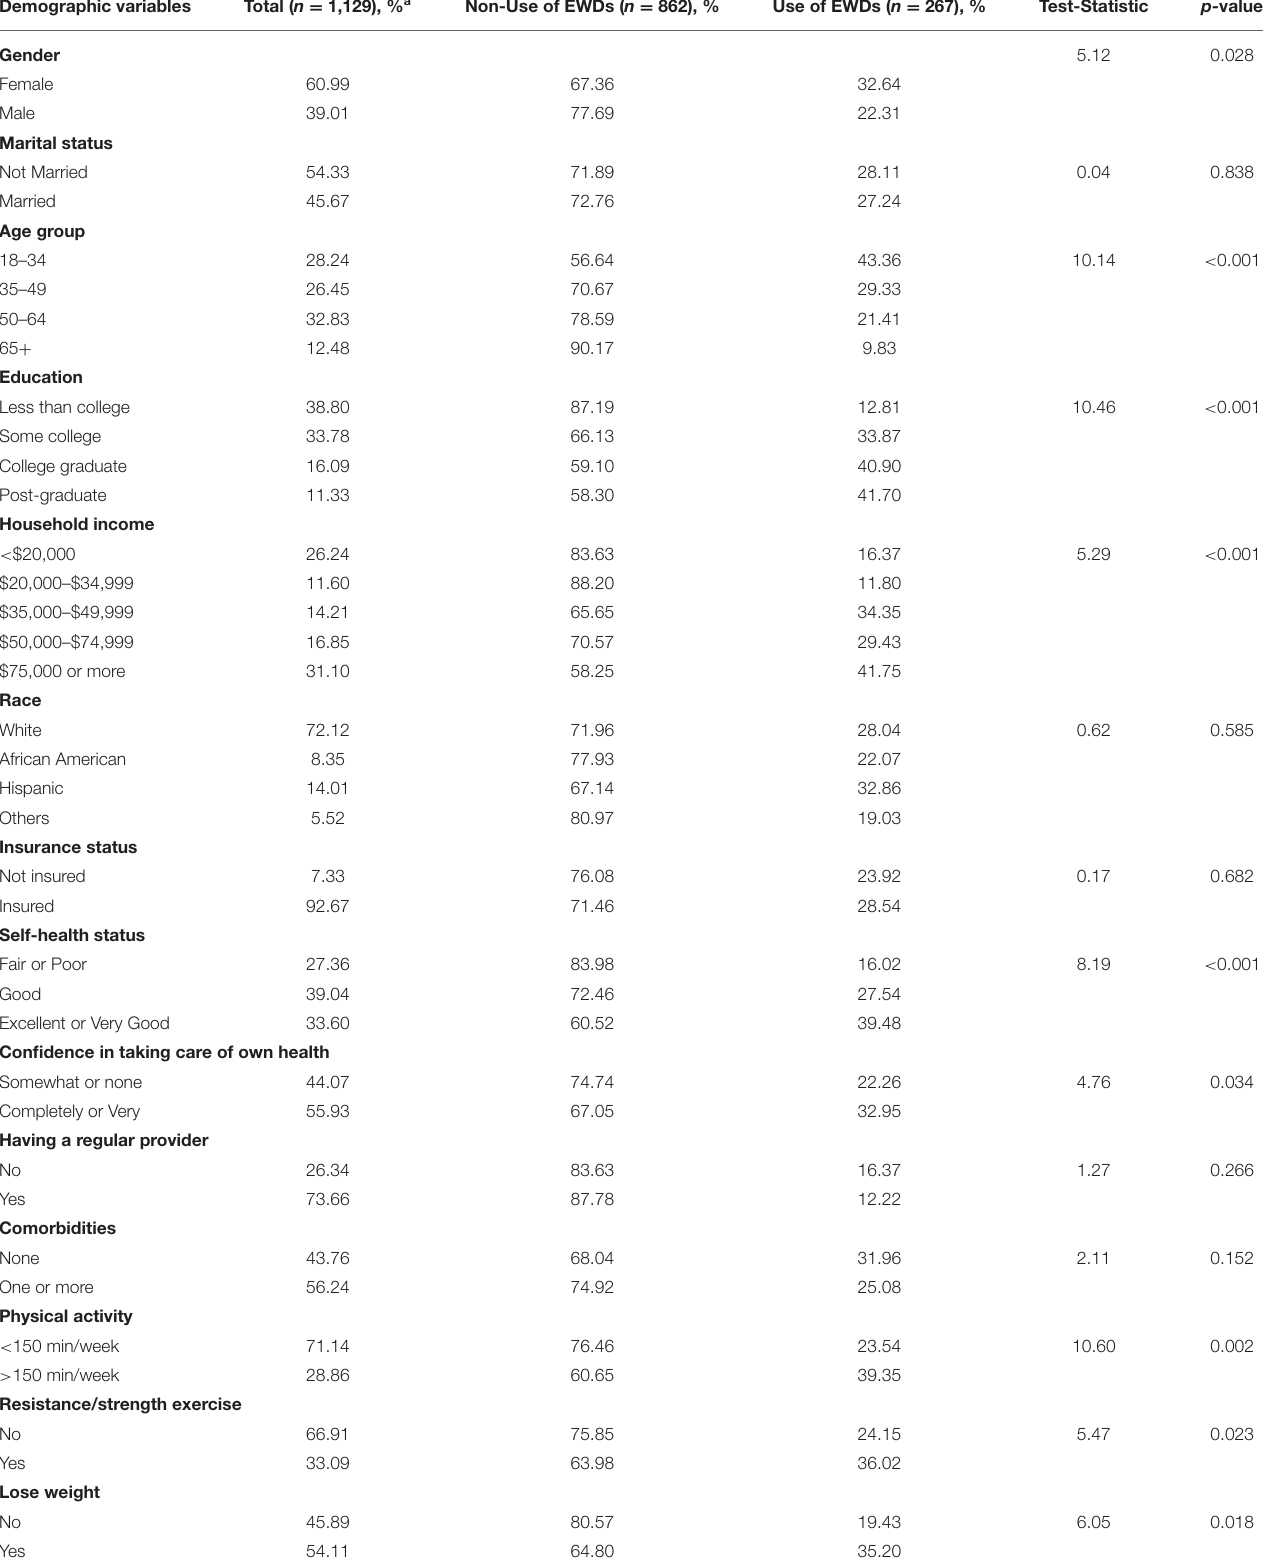
TABLE 1 | Sample population demographic characteristics: sample n = 1,139. Demographic